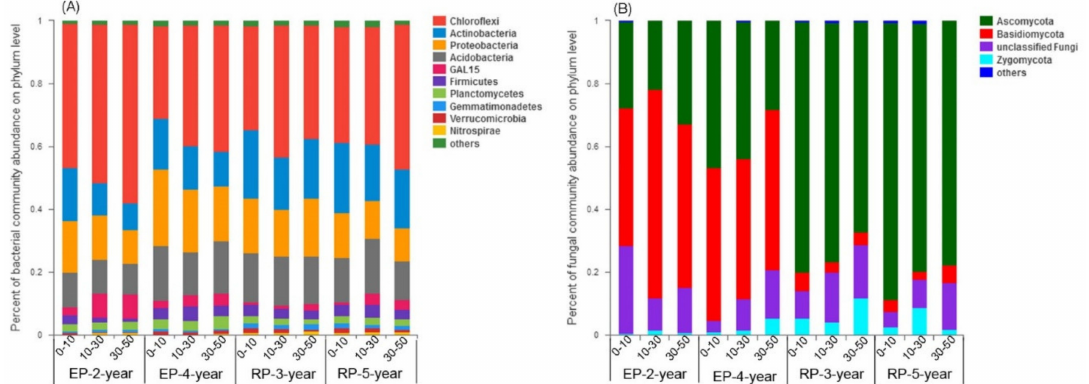
Figure 1. Percent of microbial communities’ abundance on phylum level along three soil depth (0–10 cm, 10–30 cm, 30–50 cm) under 2-year-old and 4-year-old Eucalypt plantations (EP-2-year and EP-4-year) and 3-year-old and 5-year-old Rubber plantations (RP-3-year and RP-5-year). ( A ), percent of the top bacterial phyla abundance. ( B ), percent of the top fungal phyla abundance. The phyla with abundance less than 0.01 percent were defined as others.